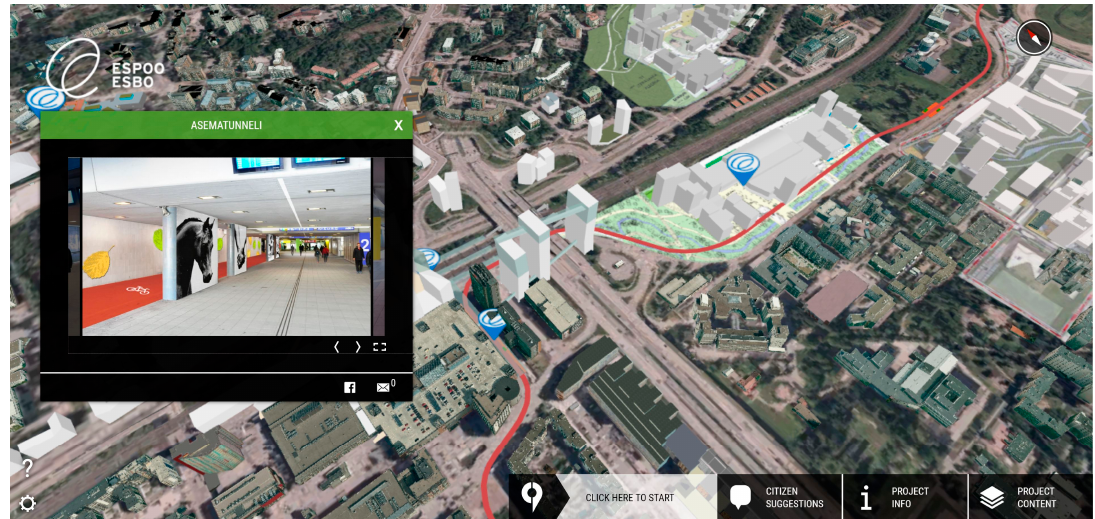
Figure 1. Mission Leppävaara pilot aims to encourage citizens to participate in the urban planning process within the Leppävaara district in Espoo [47].